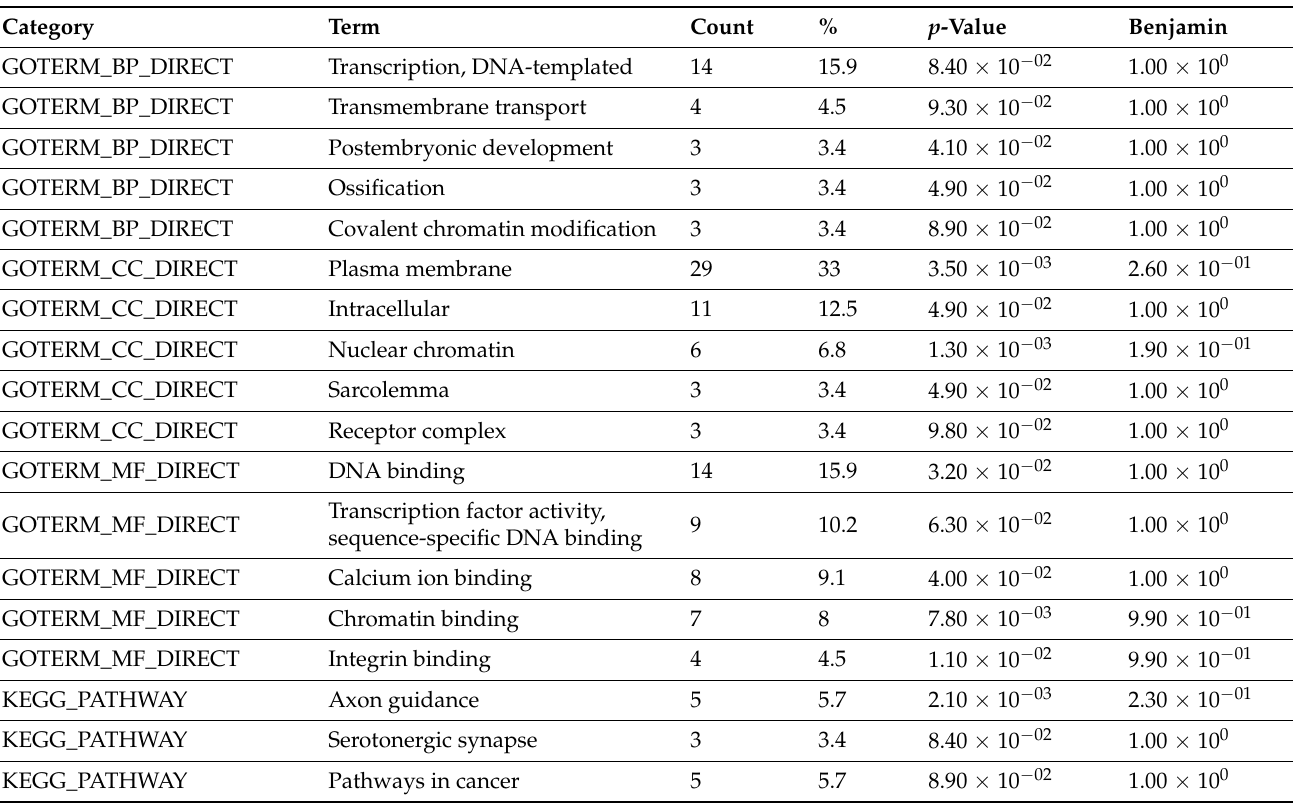
Table 3. Top five gene ontology (GO) terms and Kyoto Encyclopedia of Genes and Genomes (KEGG) pathways enriched for upregulated DEGs.